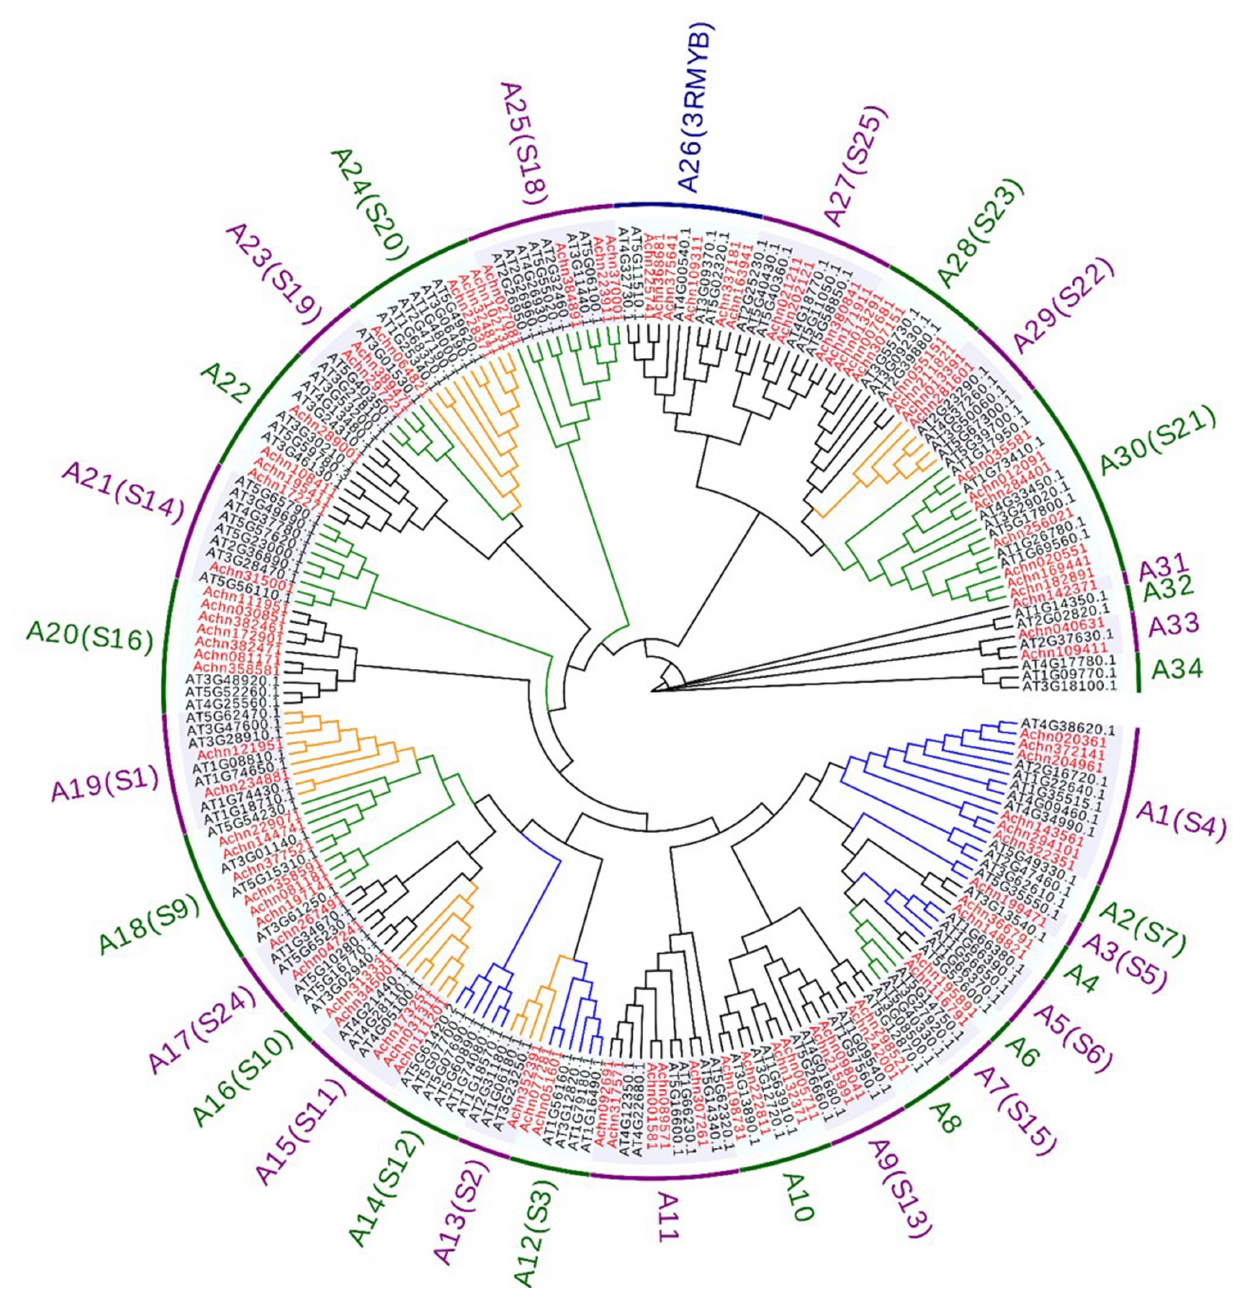
Figure 2. Phylogenetic analysis of R2R3-MYB , Arabidopsis thaliana classification S1–S25 with reference to Dubos [2], with red as AcMYBs and black as AtMYBs , orange line as stress response-related MYBs , blue line as metabolism-related MYBs and green line as growth-related MYBs .